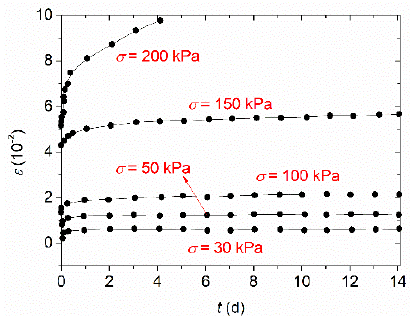
Figure 9. Creep curves of soft marine soil under different stresses. Table 1. Parameters of the fitting equation at each stress level.